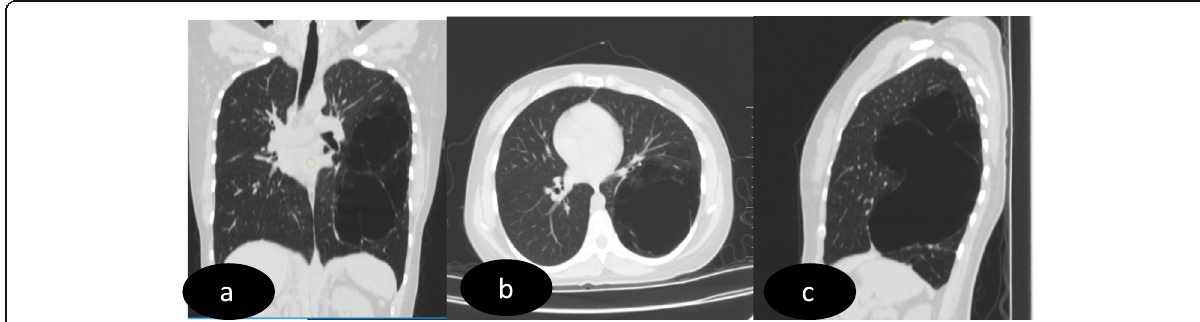
Fig. 2 a Coronal, b axial, and c sagittal images of the CT chest show large bullous lesion in the left lung with few tiny internal septations and no evidence of fluid level/collection